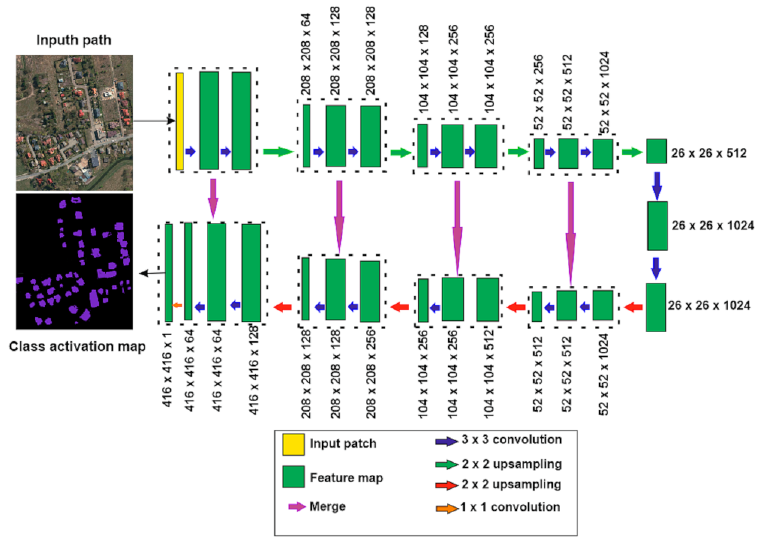
Figure 3. U-Shape Network (U-net) architecture used (based on